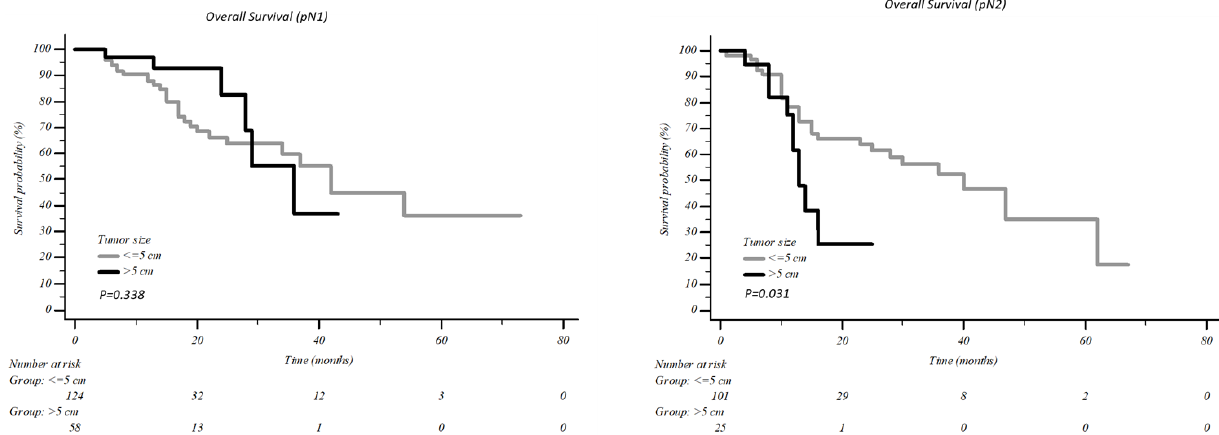
Figure 3. Overall survival according to the tumour dimension in patients with pN1 and pN2.